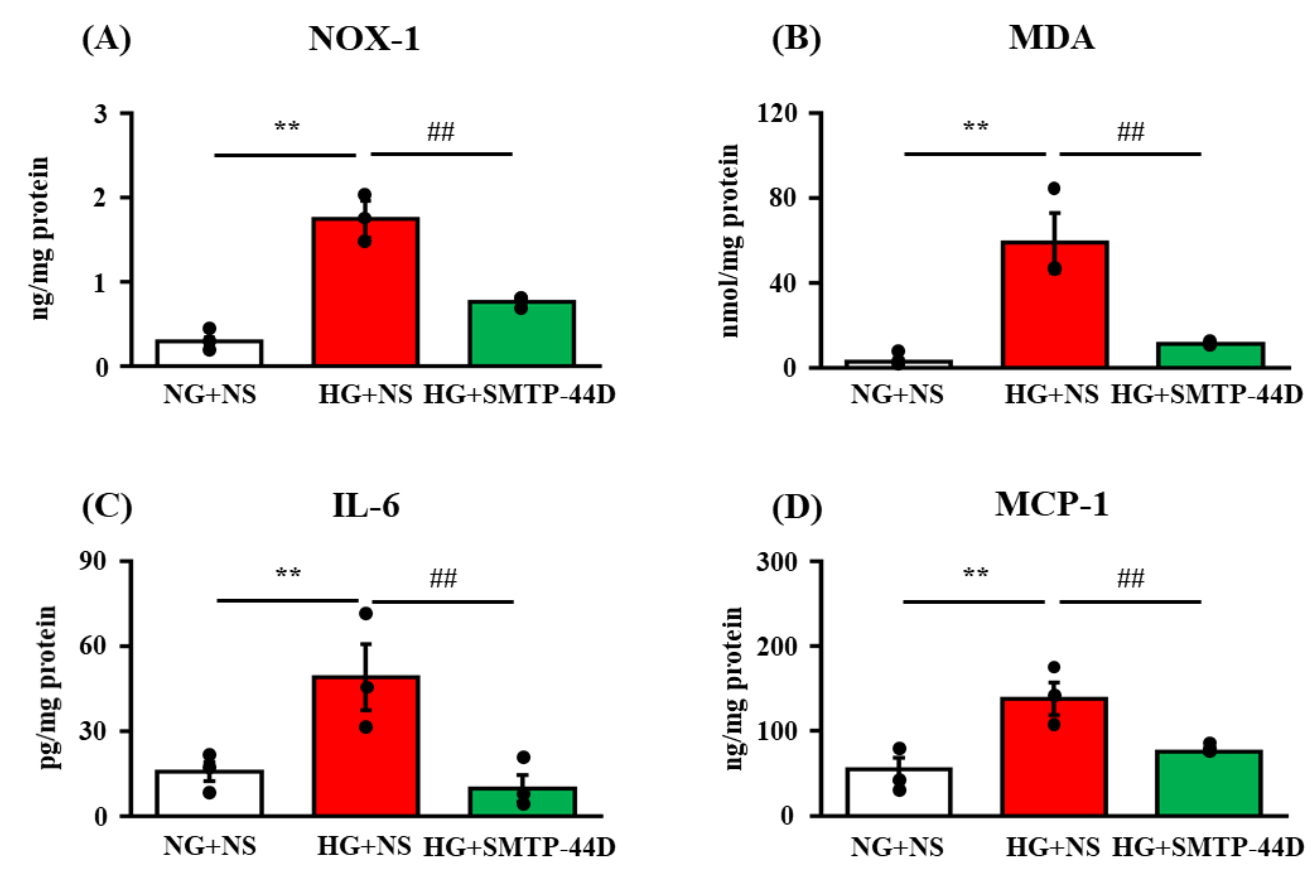
Figure 3. The levels of NOX-1 ( A ), MDA ( B ), IL-6 ( C ), and MCP-1 ( D ) in response to SMTP-44D in IMS32 cells under high glucose conditions. IMS32 cells were incubated with SMTP-44D (30 μ M) from 48 to 96 h after the HG treatment. The levels of NOX-1 ( A ), MDA ( B ), IL-6 ( C ), and MCP-1 ( D ) were determined 96 h after the HG treatment. The data are expressed as the mean ± S. E. M. ( n = 3). ** p < 0.01 vs. NG + NS group; ## p < 0.01 vs. HG + NS group by one-way analysis of variance followed by Bonferroni test. NG, normal glucose; HG, high glucose; NS, normal 2.4. Effects of SMTP-44D on Apoptosis in IMS32 Cells under High Glucose Conditions TUNEL-positive cells were measured to detect Schwann cell apoptosis. Figure 4 shows the effects of SMTP-44D on apoptosis, as assessed by the TUNEL assay at 96 h. In the HG + NS group, the number of TUNEL-positive cells ( p < 0.05, 1.66 0.34%) was sig- nificantly higher than that in the NG + NS group (0.54 0.16%). The HG + SMTP-44D (30 μ M) treatment group showed a significant decrease in the number of TUNEL-positive cells ( p < 0.05, 0.62 0.35) compared to that in the HG + NS group.